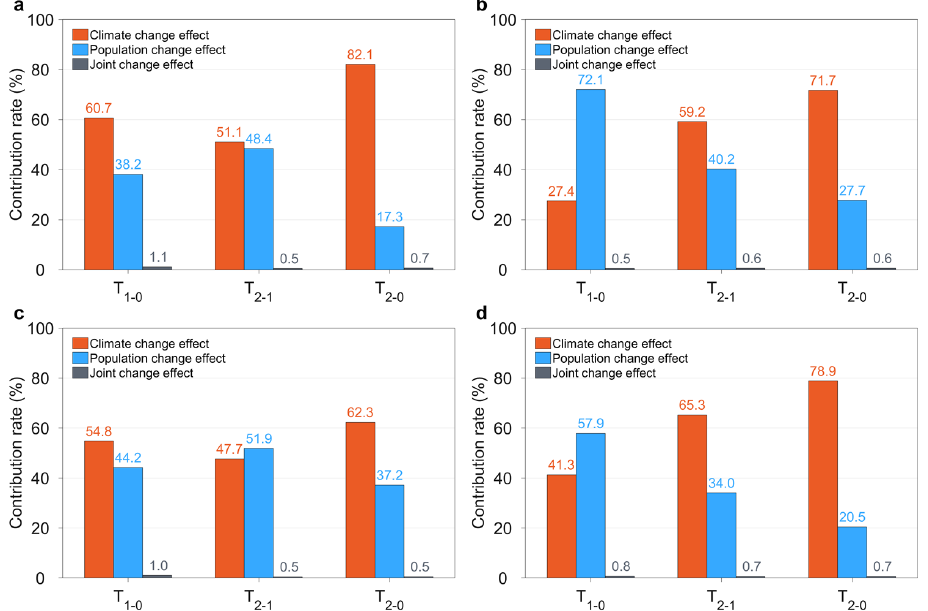
Figure 5. Breakdown of the change in population exposure for each scenario in the Northwest Pacific. ( a – d ): Breakdown of the change in population exposure for tropical cyclone hazard scenarios I, II, III, and IV, respectively.